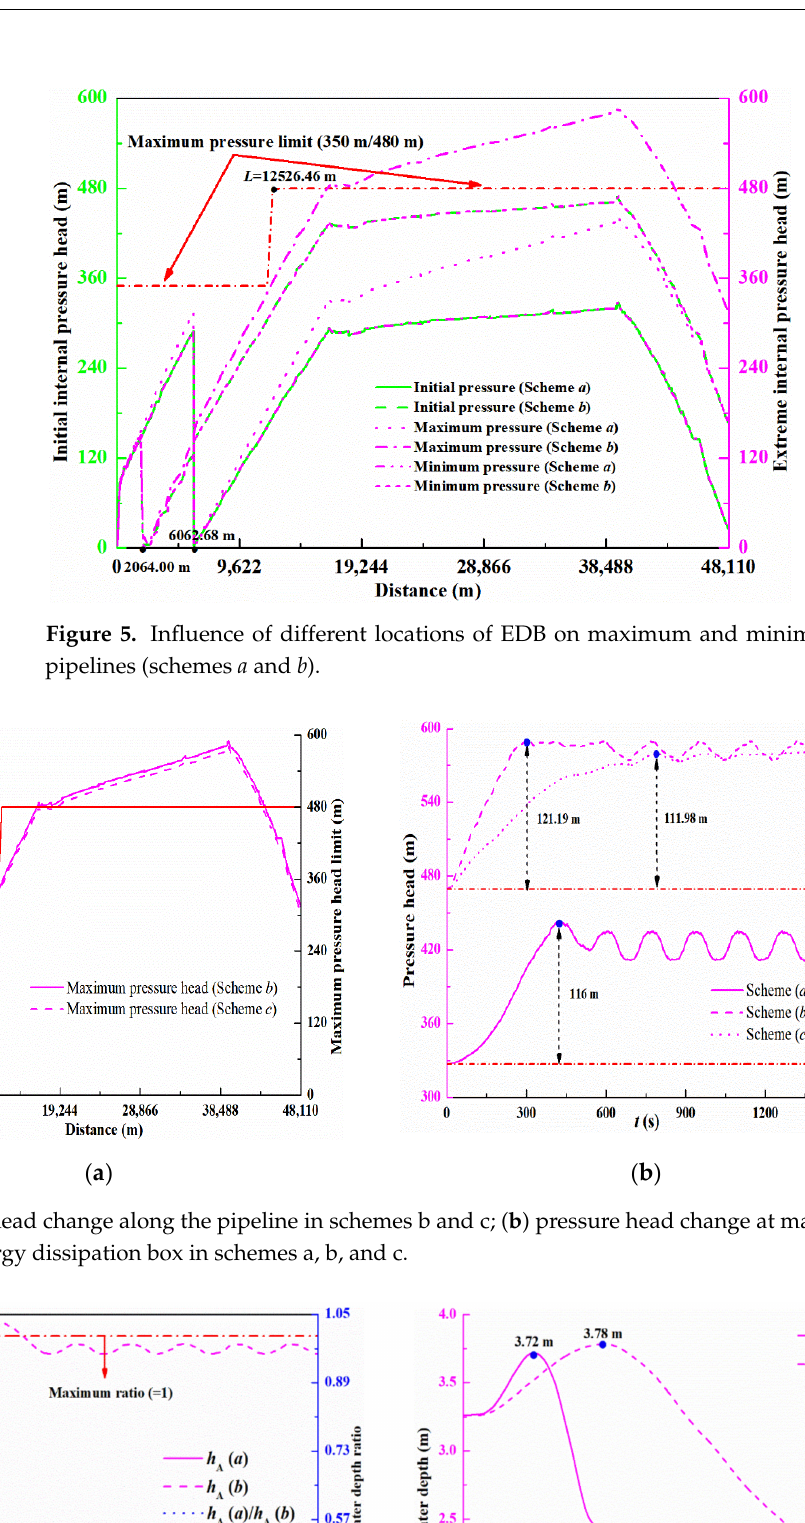
10 of 15 Table 3. Extreme pressure head along pipeline for different schemes.